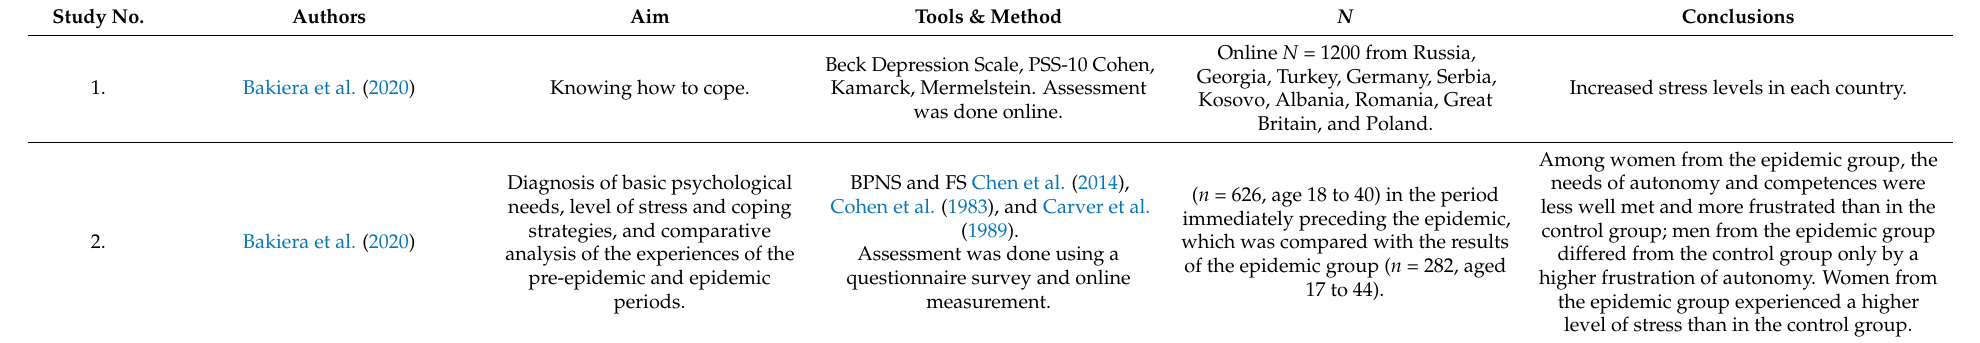
Table 2. The results of the studies on experiencing the coronavirus disease 2019 (COVID-19) pandemic in Poland and throughout the world. Study